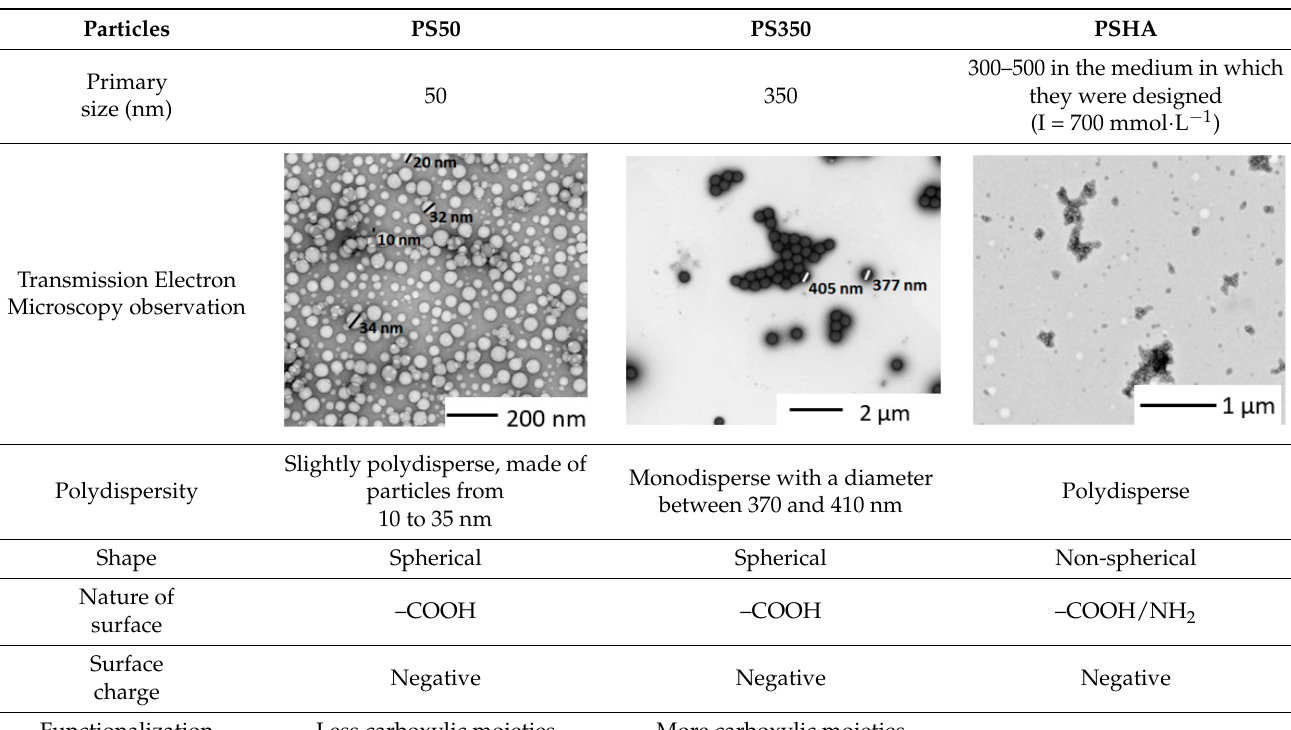
Table 1. Physico-chemical characteristics of PS50, PS350, and heteroaggregates in pure water (for more details, see [32]).